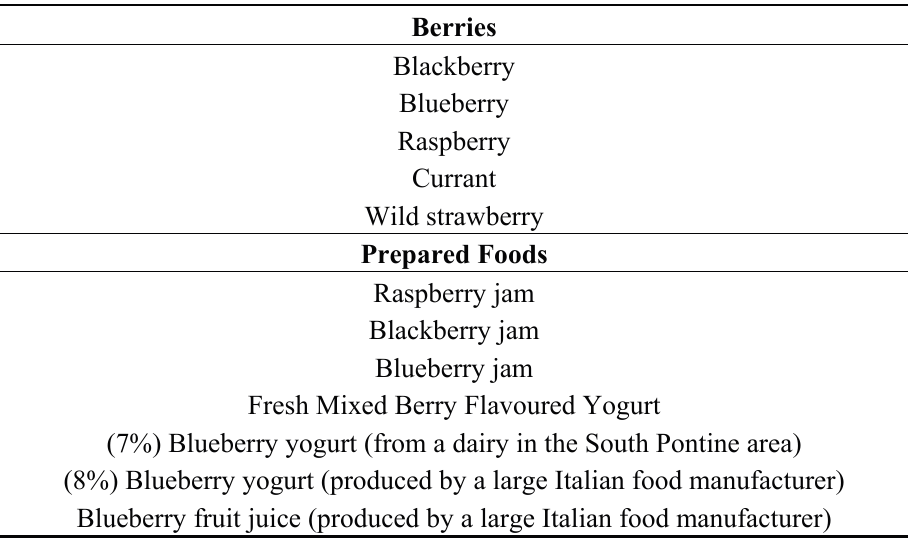
Table 1. Mixed berries and mixed berry food derivatives analysed in the present